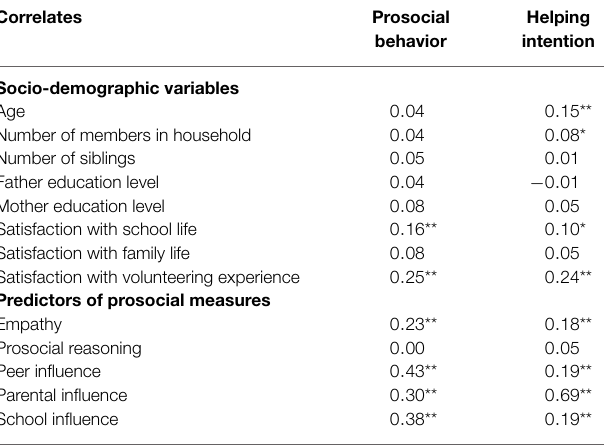
Helping behavior intention